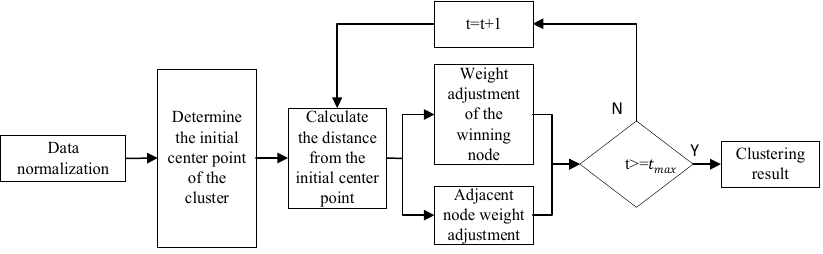
Figure 1. The Kohonen algorithm flow chart.